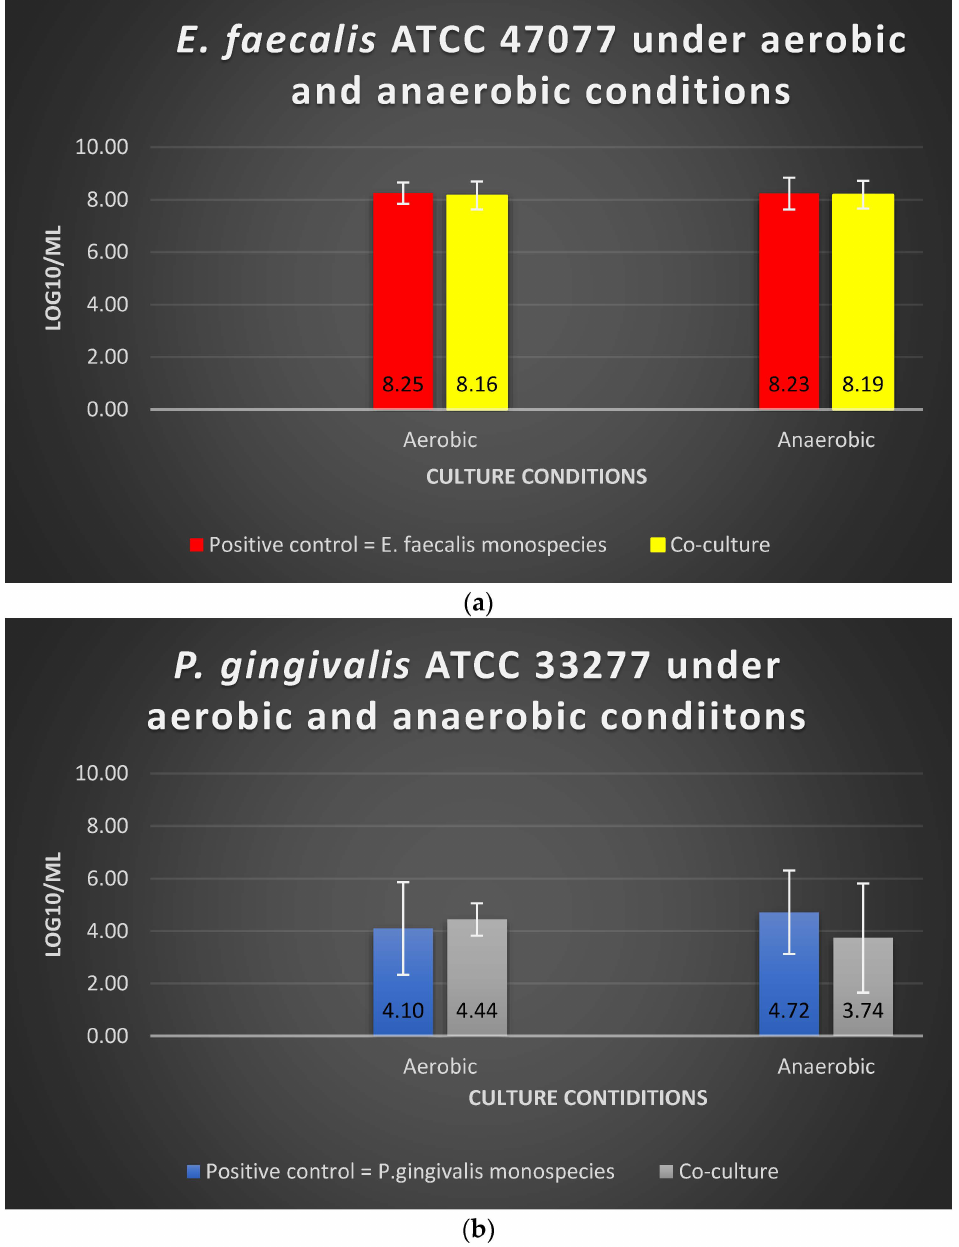
Figure 3. The viability of ( a ) E. faecalis and ( b ) P. gingivalis , cultured independently under aerobic and anaerobic conditions based on the co-culture and mono-culture models. Data represent the mean and standard